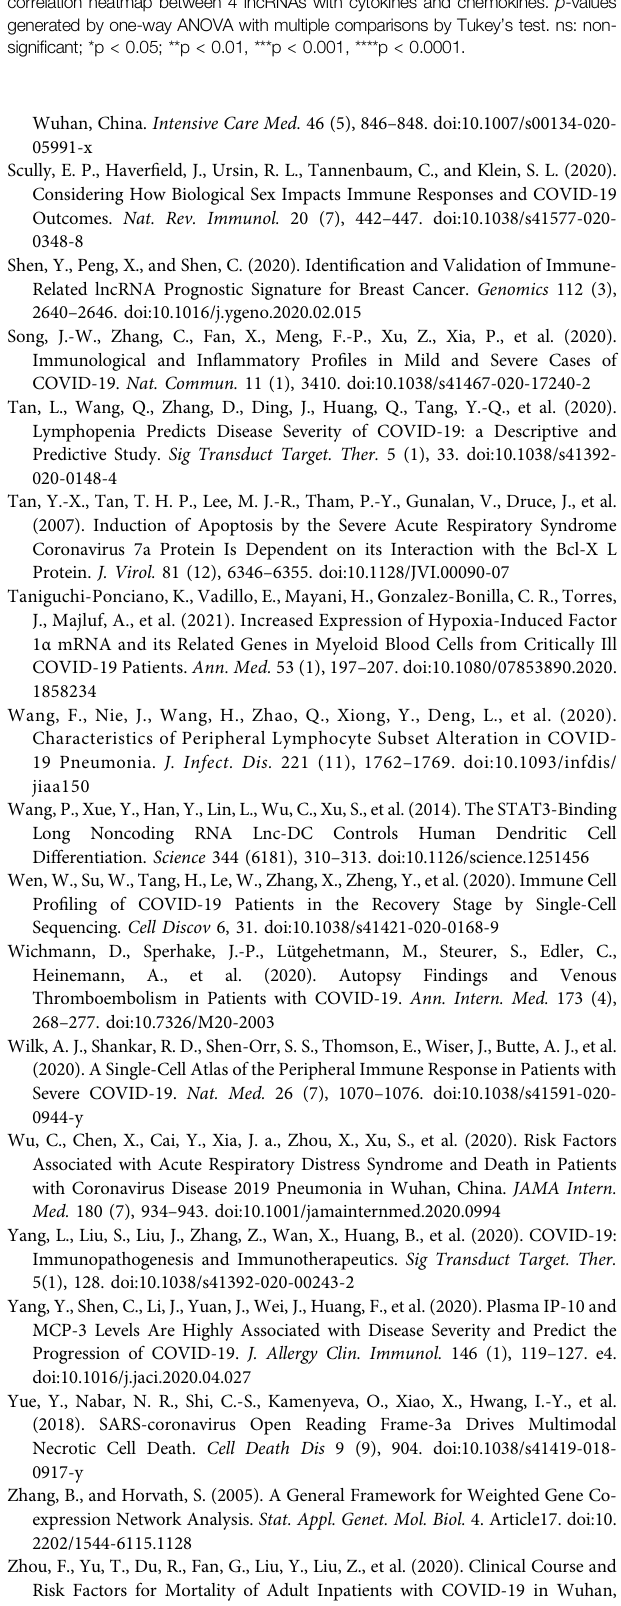
Supplementary Figure S6 | Cytokineand chemokinepro fi lesinCOVID-19patients. (A) Heatmap of DE genes related to monocytes; (B) number of genes in 17 immune- related pathways; (C) heatmap comparison of chemokines and cytokines; (D)